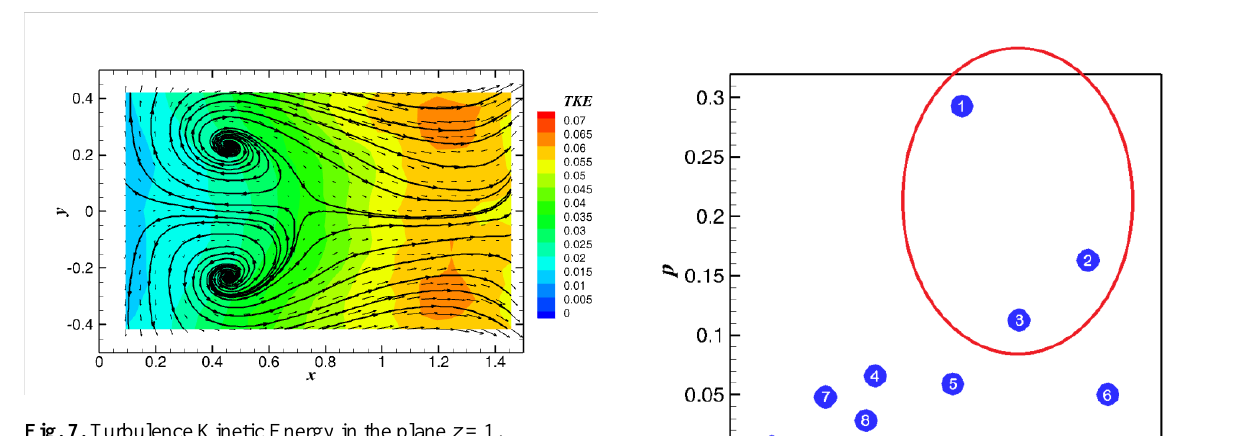
modes with the p above 0.1, within the red zone in Figure 9.